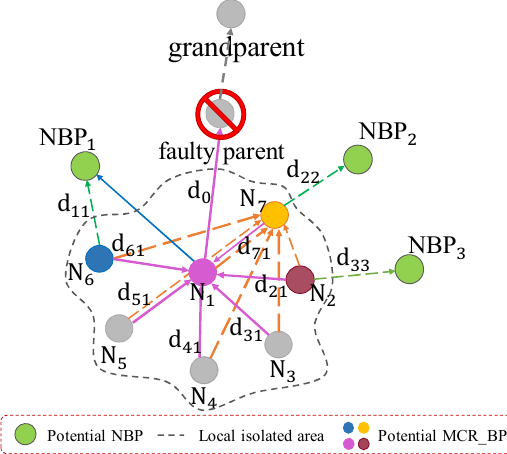
Figure 9. Example sub-tree of network where NE-MCR selects an optimal NBP.